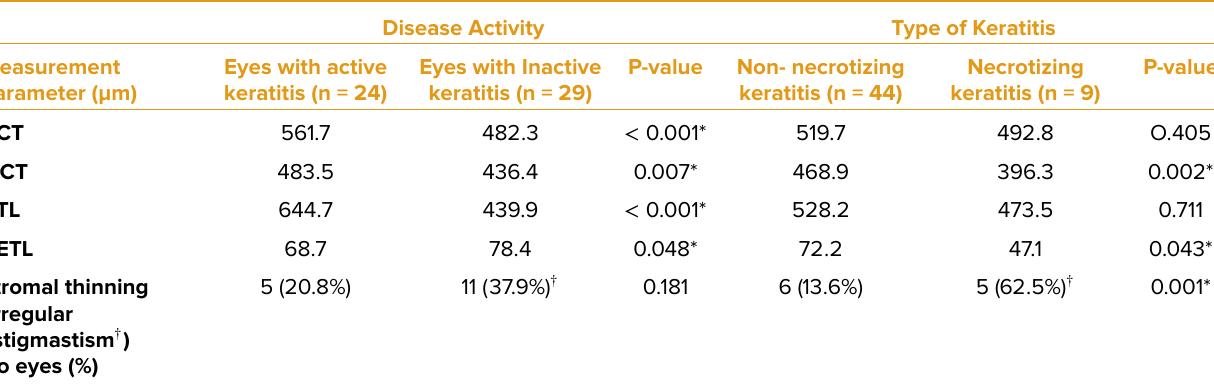
Table 3. Mean pachymetry measurements by SD-OCT of corneas with herpetic stromal keratitis according to inflammatory status and type of keratitis.